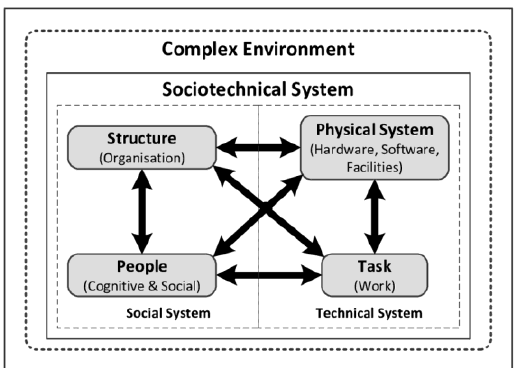
Fig. 1 : Sociotechnical system (STS) –